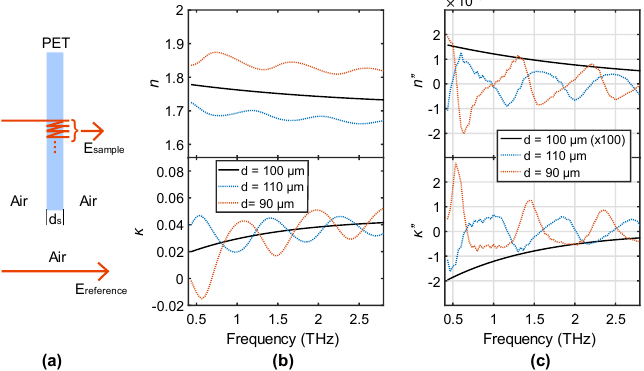
Figure 1. ( a ) Schematic of the transmission measurement of a PET (polyethylene terephthalate) thin film; ( b ) Extracted n and κ and ( c ) their second order derivatives when using the thickness of 100, 110, and 90 μm.